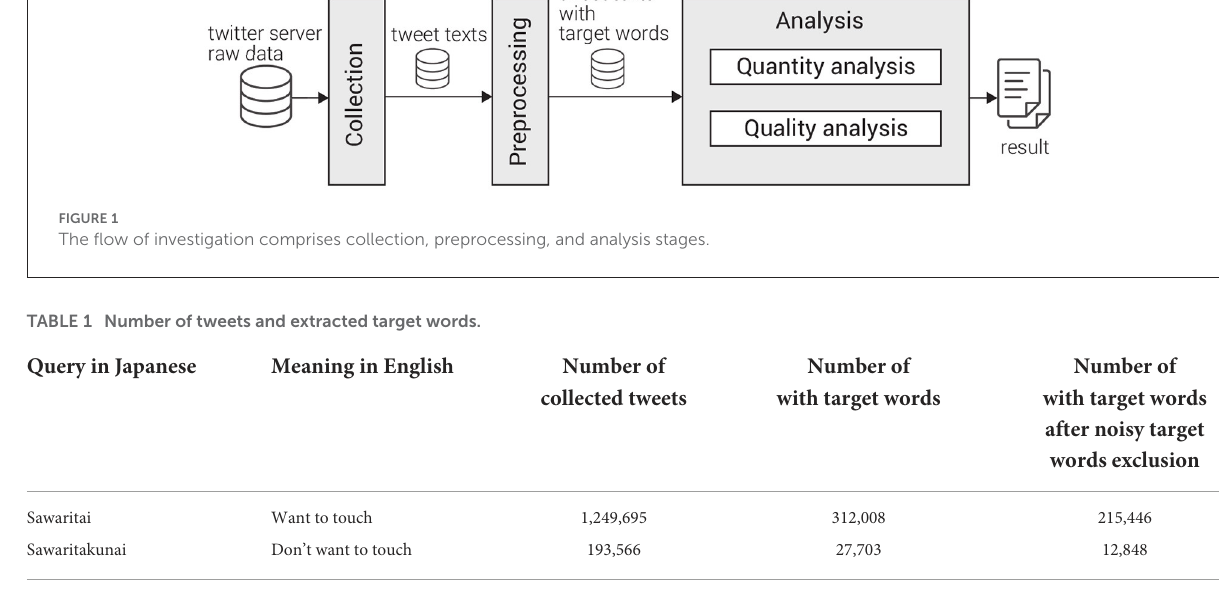
collected tweets